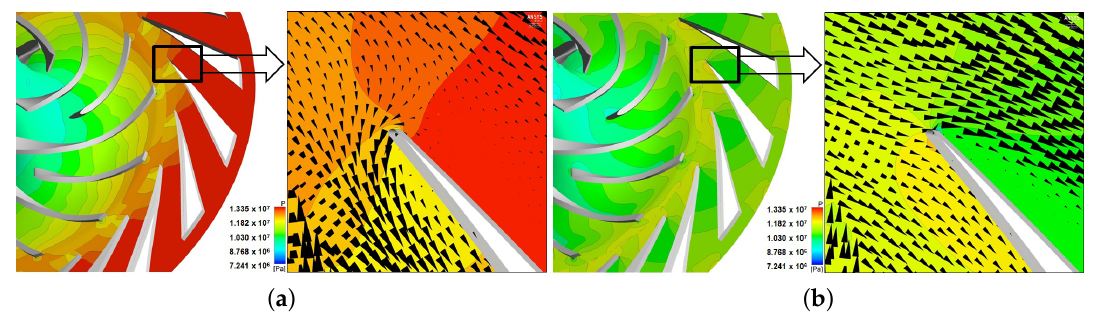
Figure 17. Pressure contour and velocity vector at span 50% span for impeller alone with vaned diffuser configuration. ( a ) Impeller with vaned diffuser at mass flow rate of 1.4 kg/s. ( b ) Impeller with vaned diffuser at mass flow rate of 3.8 kg/s.